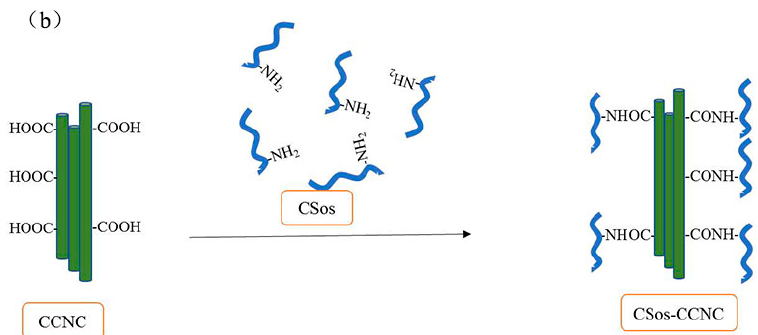
Figure 2. ( a ) FTIR spectrums of microcrystalline cellulose (MCC), CCNC, chito-oligosaccharides (CSos), and CSos-CCNC and ( b ) schematic of the synthesis process of CSos-CCNC.